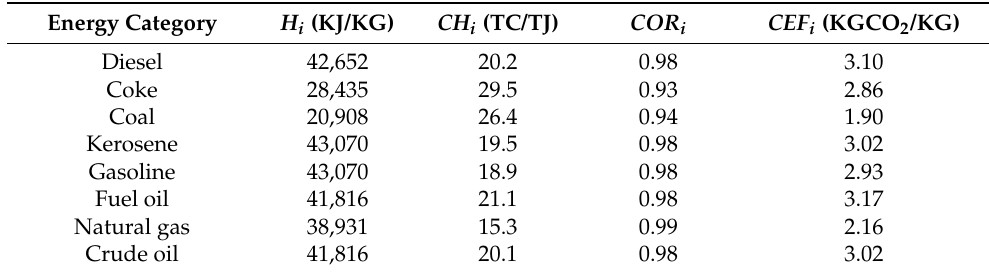
Table 1. Conversion table of carbon emission factors of major energy